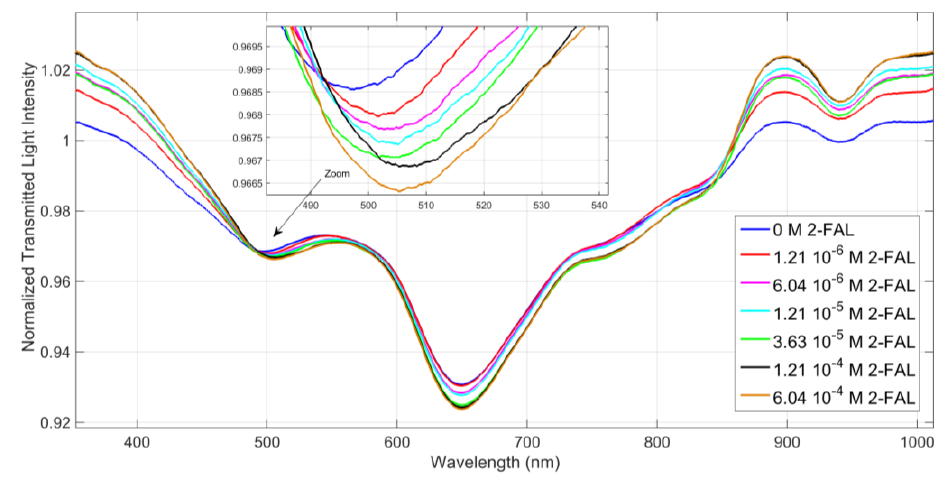
Figure 7. Normalized spectra (against the bare optical platform in air) of the D-shaped POF-MIP-SPR sensor in 75%water-25%ethanol, at different concentrations of 2-FAL in the range 1 × 10 −6 M to 6 × 10 −4 M.